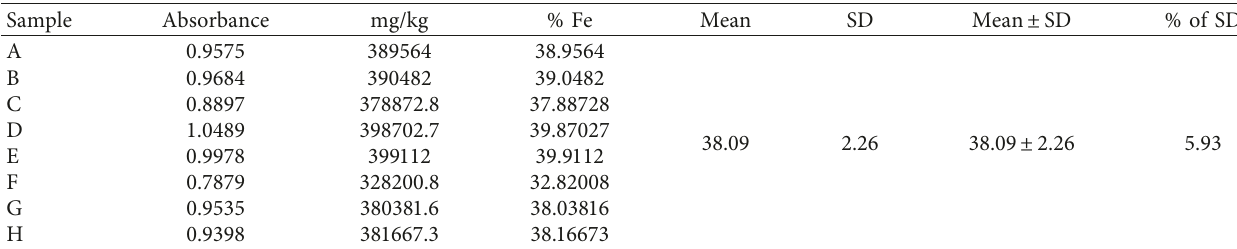
Figure 6: (a) Diagram obtained by plotting absorbance of the different concentrations of standard solutions of Fe (III) for validation. (b) Calibration curve for determination of Fe (III). (c) Amount of iron present in the ore measured by the AAS method. Table 6: Iron content values of different samples of hematite ore determined by the AAS measurement method. The mean value in the table represents the mean of samples for each channel assigned from A to